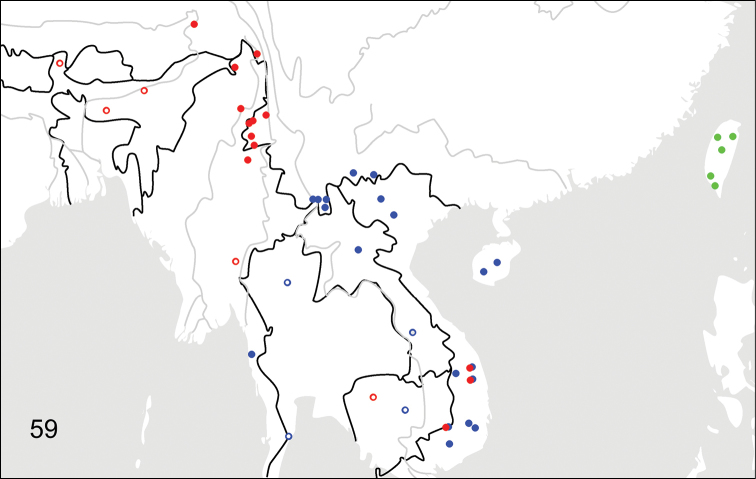
Distribution map for P.
acutidens sp. n. (red); P.
ornatus
ornatus Schmidt-Göbel (blue); P.
ornatus
formosanus Dupuis (green); dubious records marked by hollow spots.